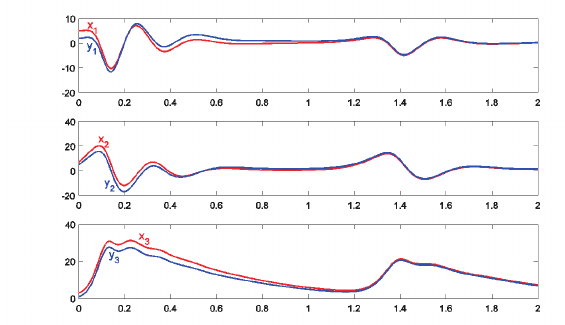
Fig. 3: Synchronizaton of the drive and the response chaotic sys- tems.